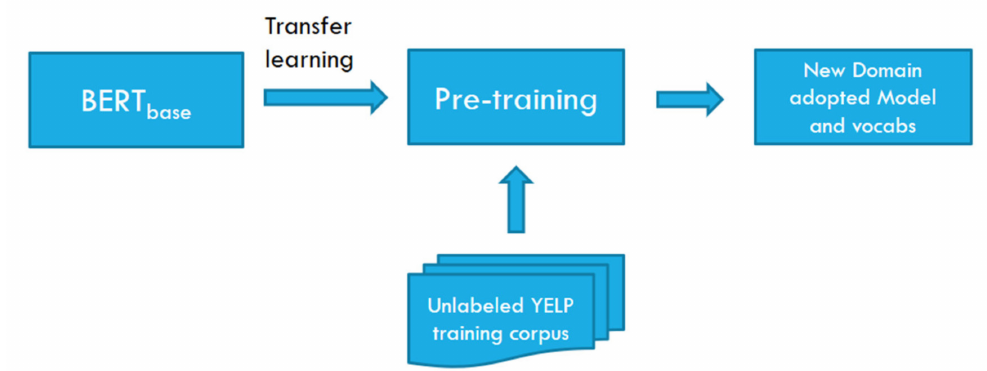
Figure 1. Further pre-training Pipeline of BERT language